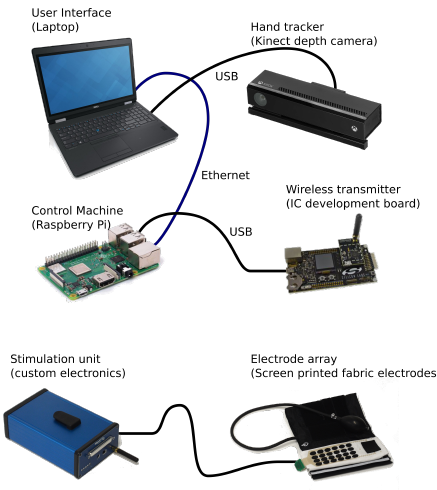
Figure 2. Overview of the SMARTmove